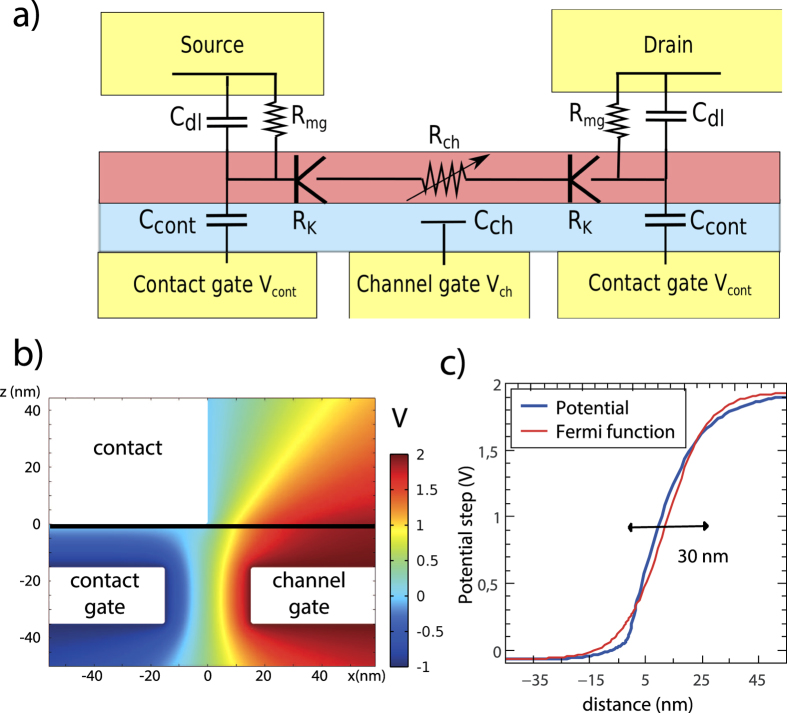
Panel (a) Equivalent circuit diagram of the sample. The contact area is represented by a resistance Rmg in parallel with an electrical double layer capacitance Cdl that stand for electrochemical balance. The doping of graphene underneath the contact is modulated through the capacitance Ccont. The “K” symbol represents the Klein tunneling junction between contact area and channel area with its associated resistance RK(Vch, Vcont).  is the diffusive resistance of the channel modulated by the channel gate through Cch. Panel (b) Electrical potential map of the device at the contact junction from finite element simulation for 2 typical channel and contact gate voltages, Vcont = −1 V and Vch = +2 V, the contact being at Vsource = 0 V. Dimensions are labeled in nanometers, the graphene layer being located at z = 0. Panel (c) Horizontal cut of the potential through the junction together with a Fermi like function. The 10–90% extension is .